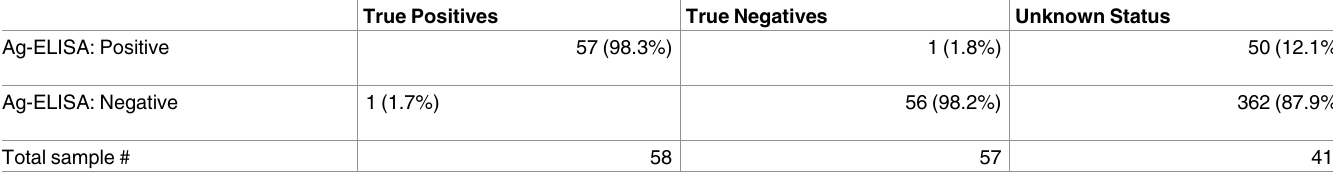
Table 1. Ag-ELISA results of gelada samples (true positive, true negative, unknown status). True Positives True Negatives Unknown Status Ag-ELISA: Positive 57 (98.3%) 1 (1.8%) 50 (12.1%) Ag-ELISA: Negative 1 (1.7%) 56 (98.2%) 362 (87.9%) Total sample # 58 57 412 True positives = samples from individualswith cysts (n = 10 individuals). True negatives = samples from unweanedinfants (n = 37 individuals). Unknown status = samples from individualswithout cysts, excluding infants (n = 158 individuals). Positive/negative assigned based on antigen presence above the optimal threshold IV cutoff (an indexed optimal density of 42.1) determined by the ROC